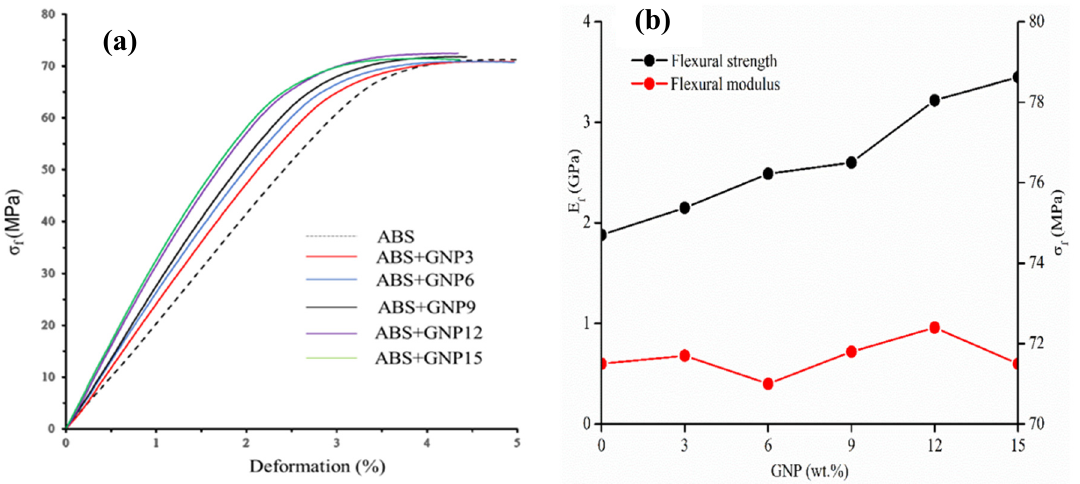
Figure 6. ( a ) The plot of flexural behavior of neat ABS and ABS+GNP composites. ( b ) Flexural strength and modulus of ABS and ABS+GNP nanocomposites.